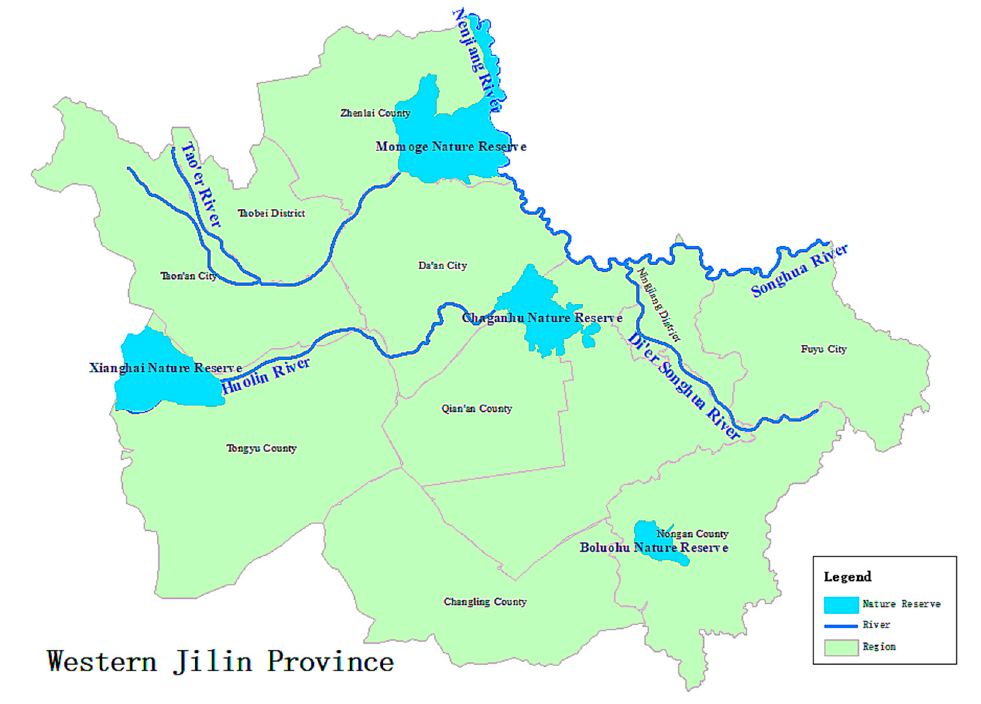
Figure 1. The sketch map of western Jilin Province.